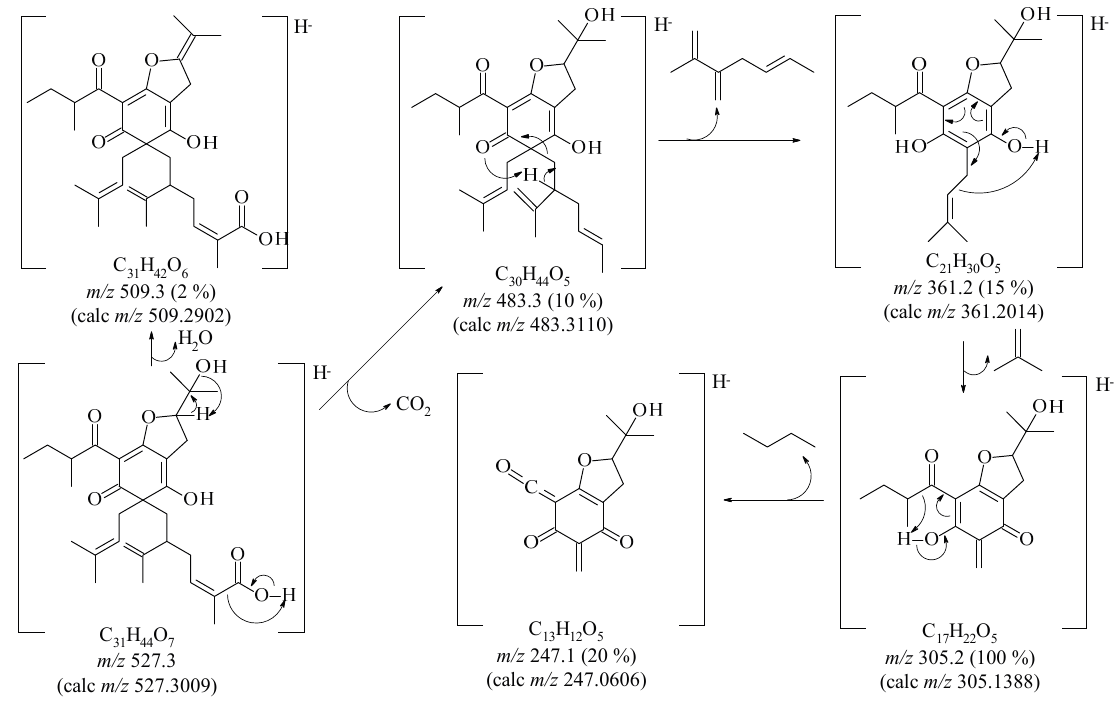
Figure 2. Proposed fragmentation to justify the principal peaks detected in the mass spectrum.